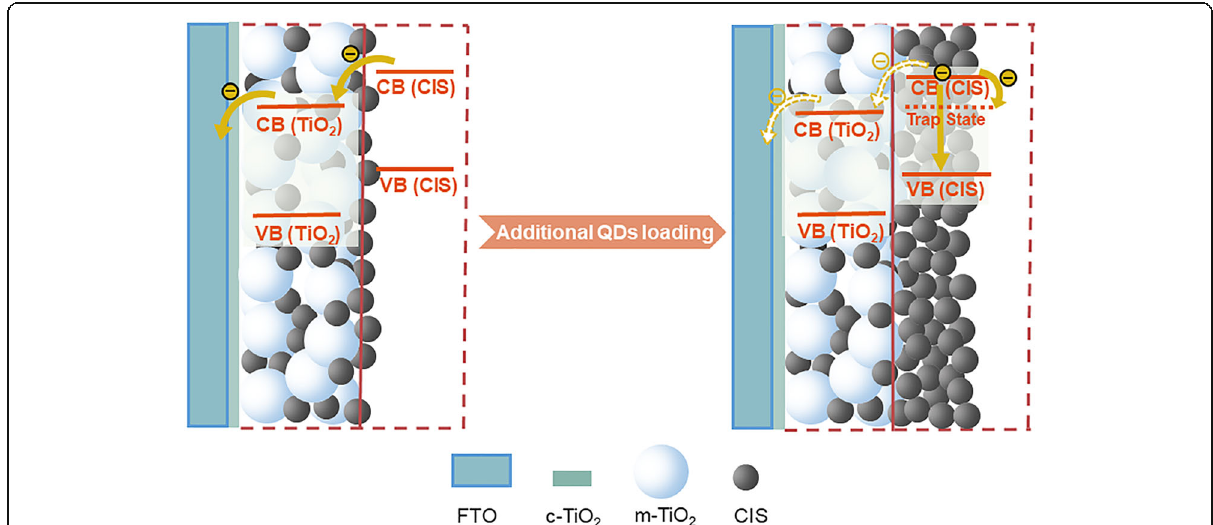
Fig. 4 Schematic diagram of the major pathways of electron transfer and charge recombination existing in QDSSCs